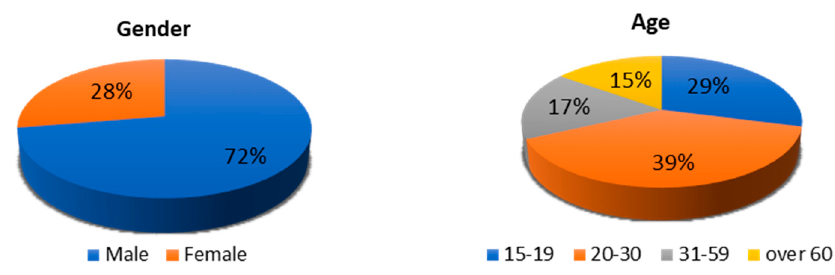
Figure 10. Participants’ distribution, gender and age.